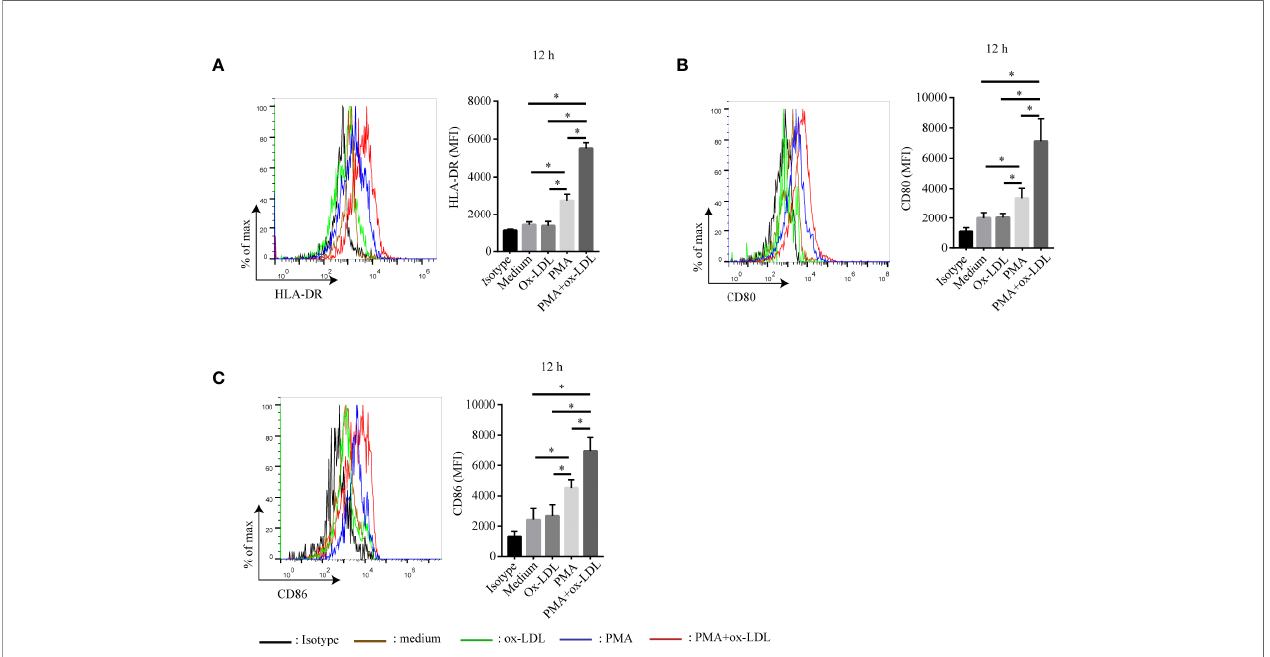
FIGURE 4 | Ox-LDL induces PMA-activated neutrophil to express HLA-DR, CD80 and CD86. Isolated neutrophils were treated under different conditions: no treatment (brown line), 40 m g/ml ox-LDL alone (green line), 1 nmol/L PMA (blue line), 40 m g/ml ox-LDL plus 1 nmol/L PMA (red line). After 12h, expression of